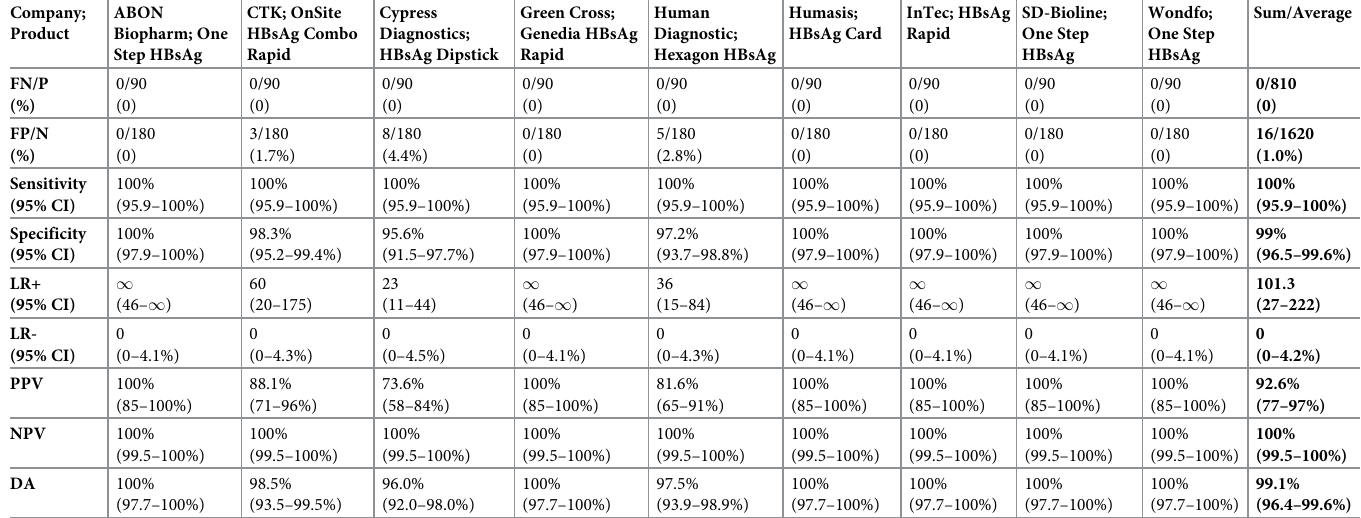
Table 3. RDTs for detection of HBsAg in blood serum. Each test was applied to 90 condition positive (P) and 180 condition negative (N) participants. Results of HBsAg ELISA served as reference standard. For the average, the 95% CI was averaged across all tests. For PPV, NPV and DA, an HBsAg prevalence of 11.0% was assumed.